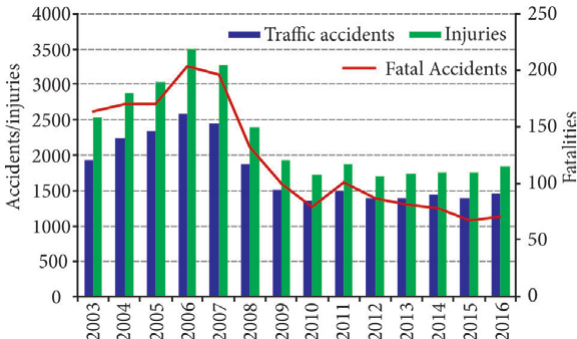
Fig. 7. Road accident fatalities and number of road